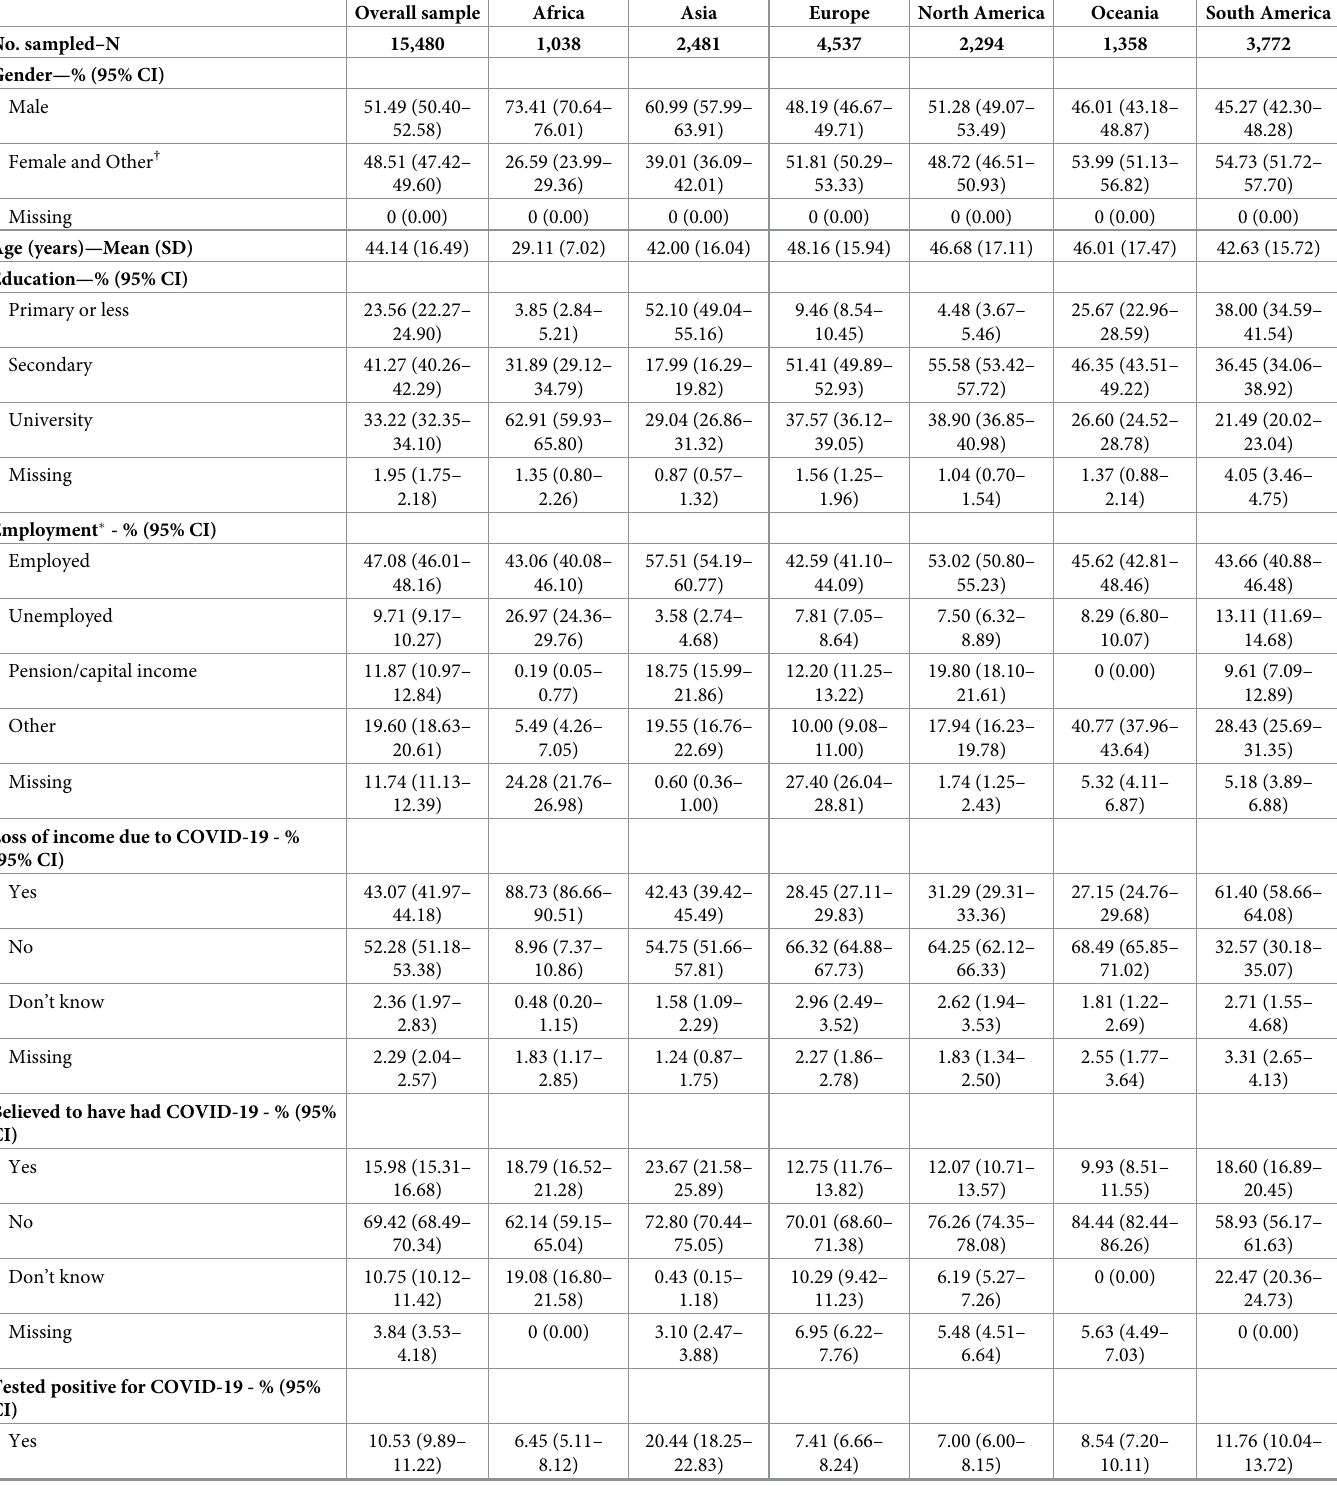
Table 1. Sociodemographic and clinical characteristics, overall and by